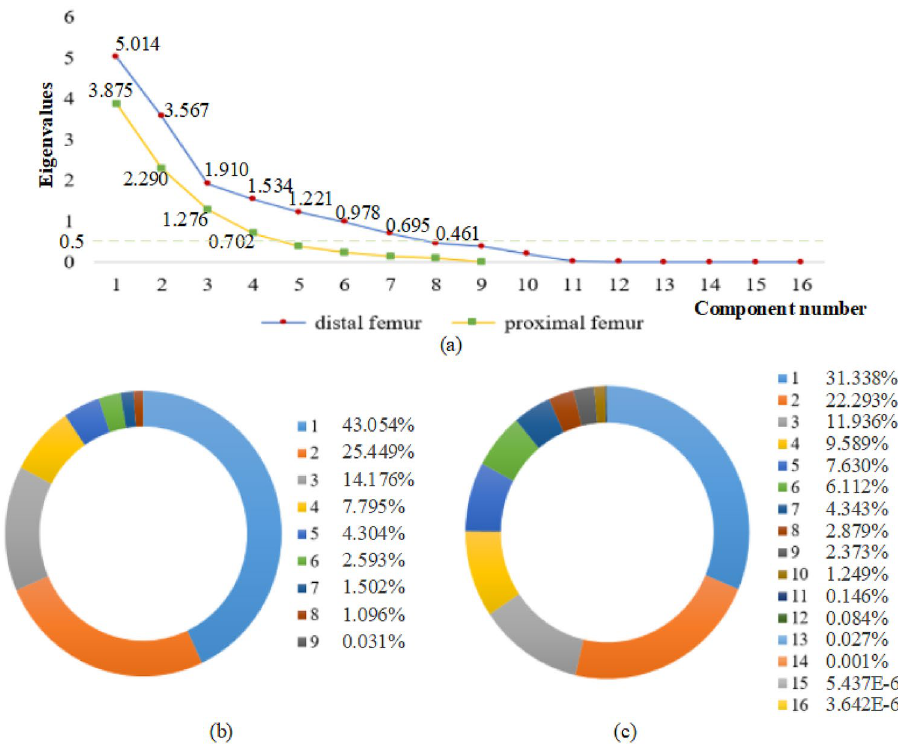
Figure 2. Components and their variance contribution rate: ( a ) components and their corresponding eigenvalues, ( b ) variance contribution rate of the components of the proximal femur, and ( c ) variance contribution rate of the components of the distal femur.